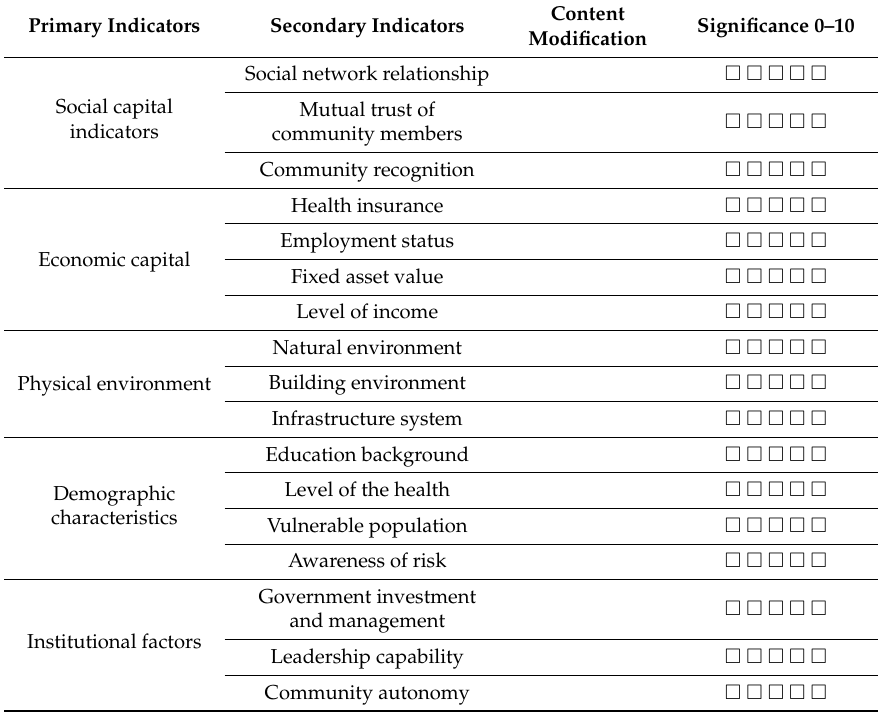
Table A1. The significance of multiple influencing